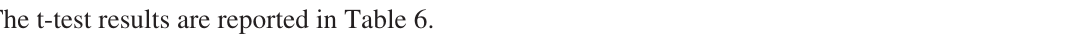
Table 6. T-test for the trading simulation results for the month-of-the-year-effect (UX